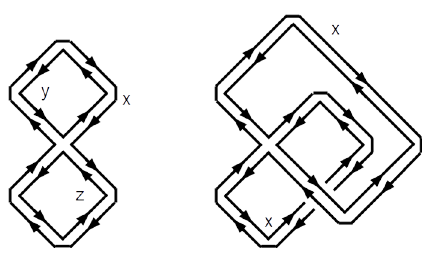
Figure 5 . The two diagrams for the computation of the two-loop two effective